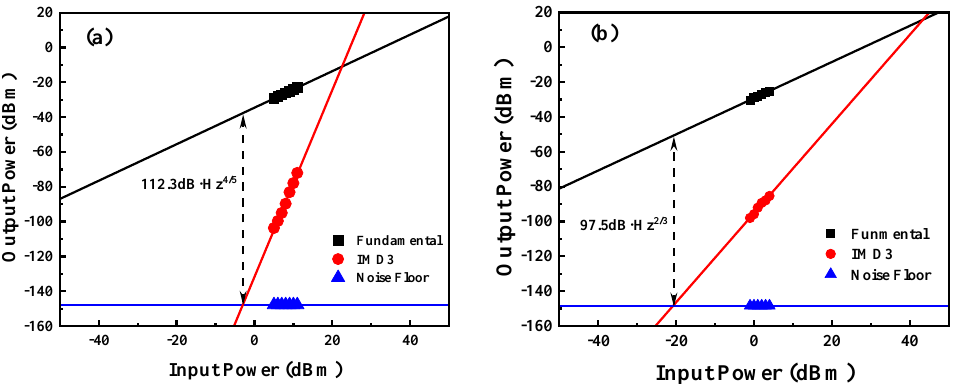
Figure 5. Measured fundamental and IMD 3 output powers as a function of the input IF signal power: ( a ) the proposed frequency up-conversion system and ( b ) the up-conversion link based on carrier suppression double-sideband modulation.